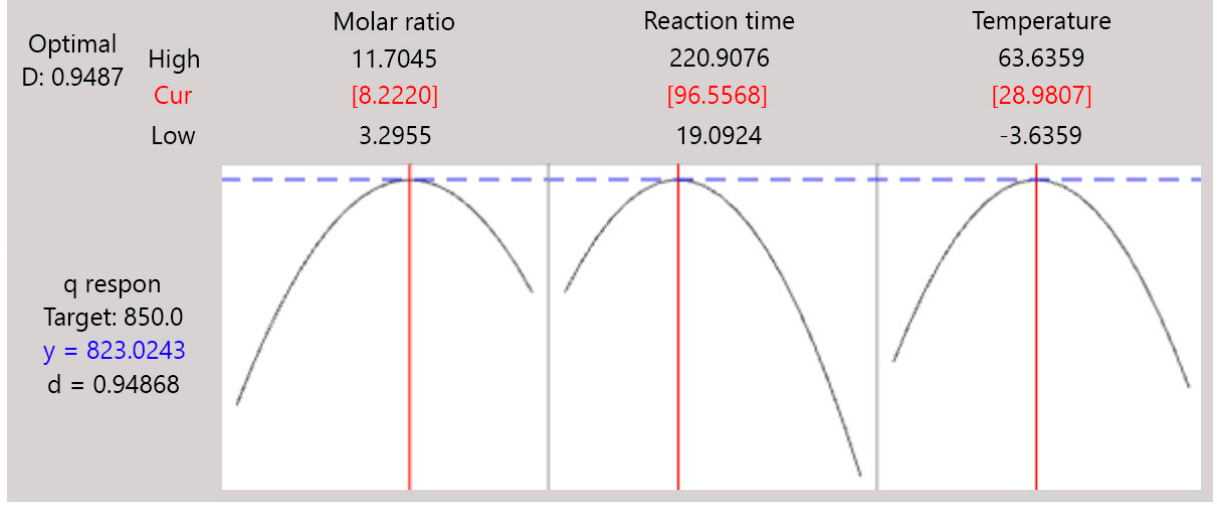
Figure 6. Optimization plots of the independent parameters for the synthesis of ZIF-L.